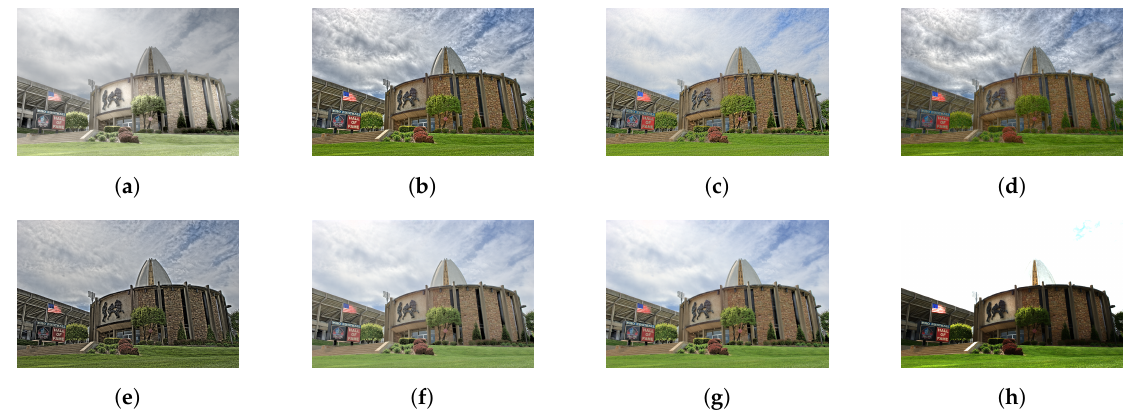
Figure 6. Comparison of tone-mapping methods. ( a ) LW [12], ( b ) WLS [28], ( c ) RoG [2], ( d ) L0 [50],